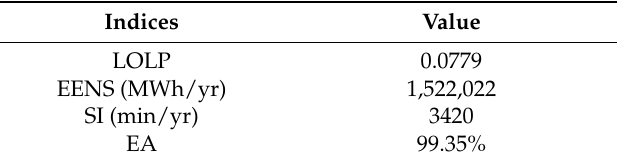
Table 4. Reliability indices of the Continental Overlay HVDC Grid (40 buses).